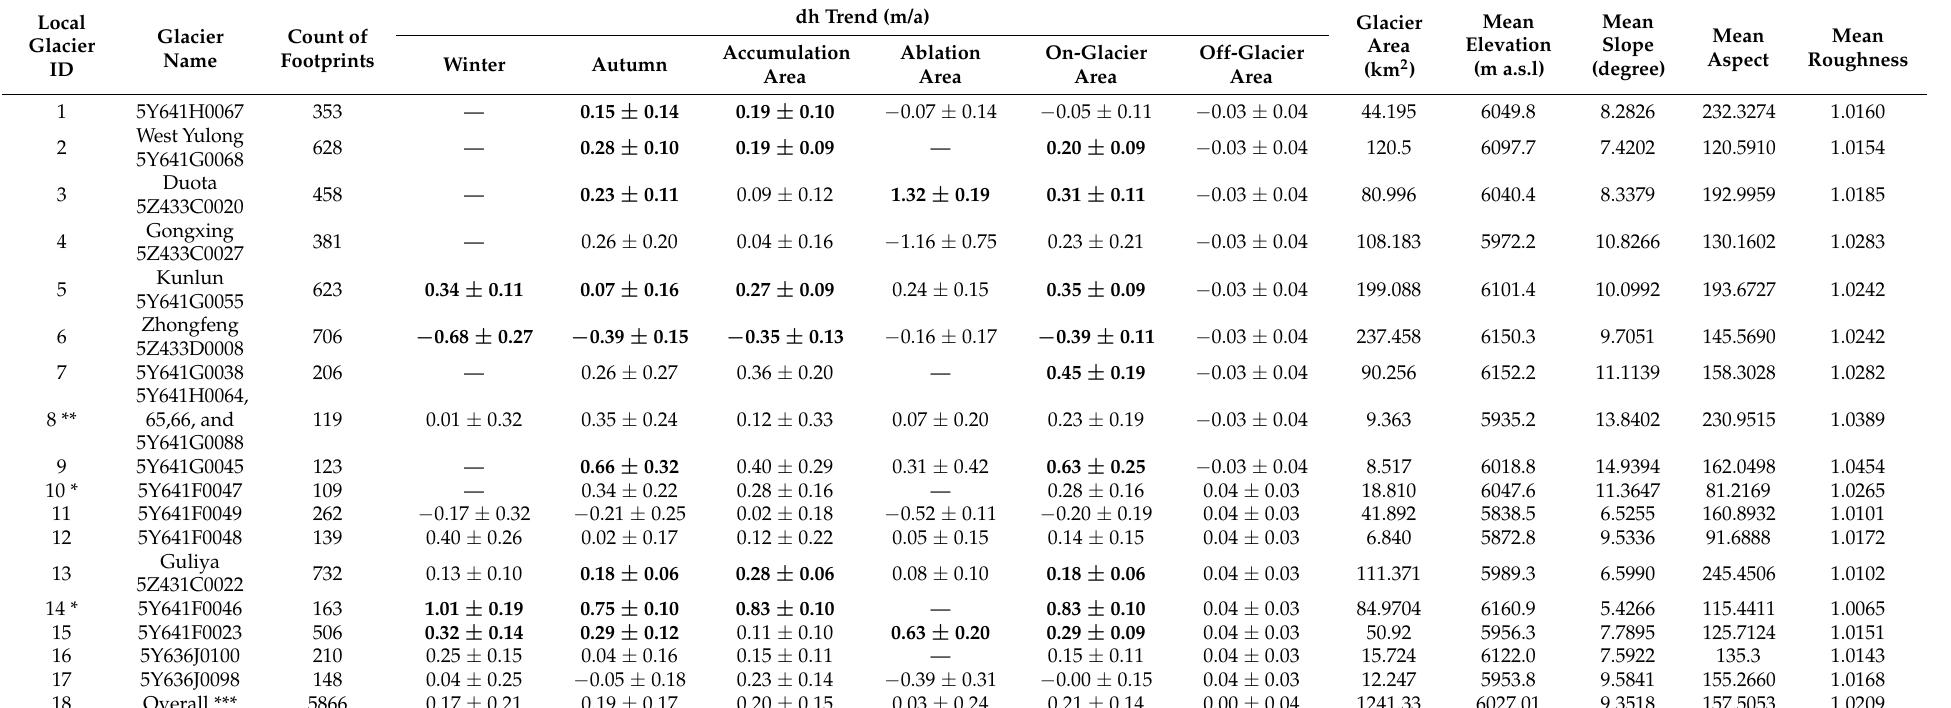
Table 1. Trends (m/a) of dh values for different parts of the glaciers and other general